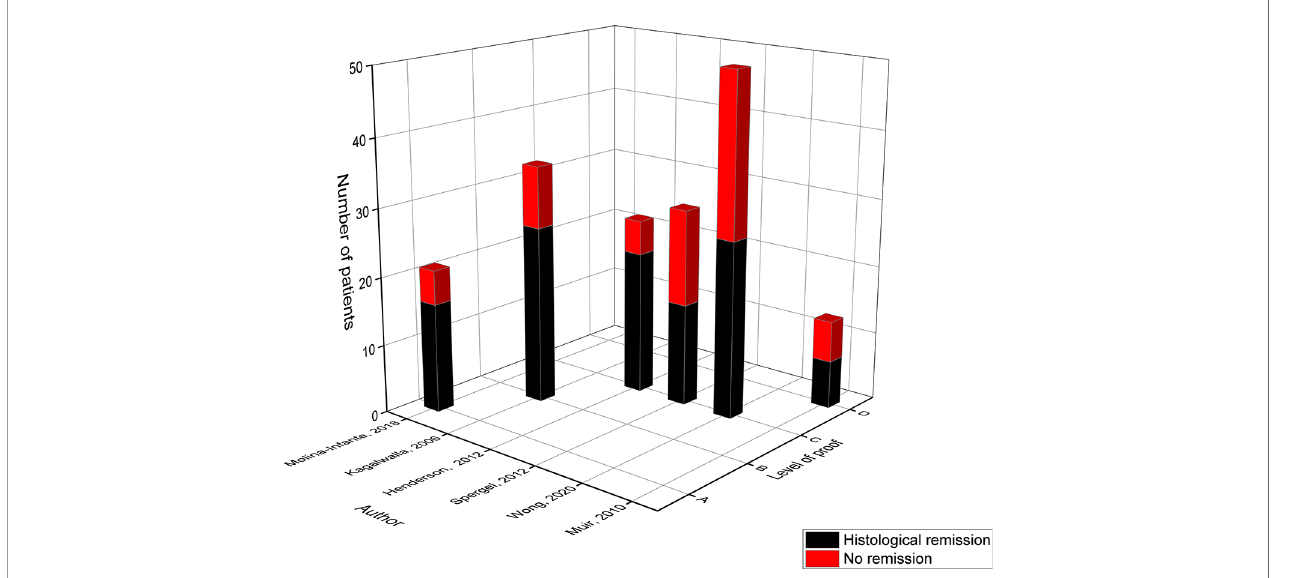
FIGURE 4 | Level of proof of studies on the 6-food elimination